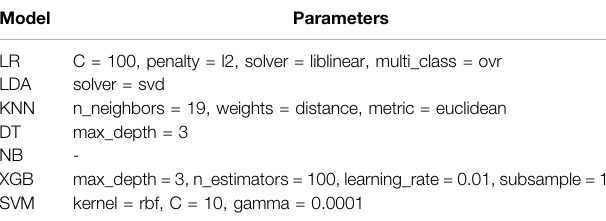
TABLE 5 | Hyperparameter tuning in validation tests. Model Parameters